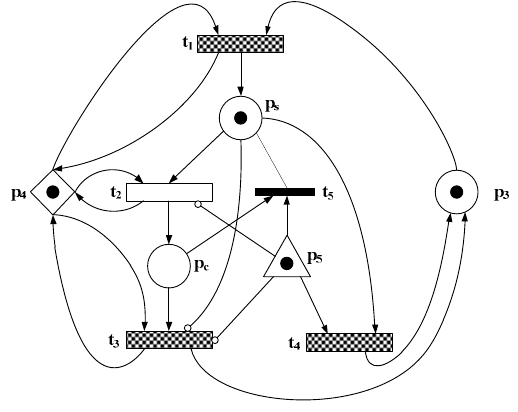
Figure 3. PN model for charging tanks.